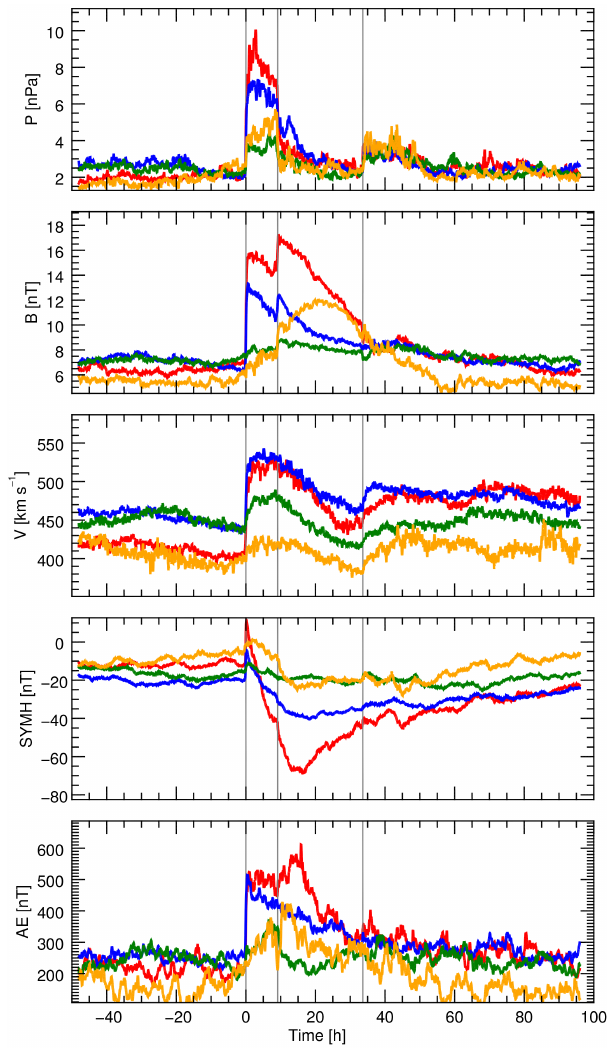
Figure 3. SEAs of three SW parameters ( B , P , V ) and two geo- magnetic indices (SYM-H and AE) for 306 ICMEs between 1996 and 2008. The three vertical lines are the epoch times indicating (re- spectively from left to right) the onset of the sheath, the onset of the ICME, and the end of the ICME. The different colors correspond to different subsets of events: ejecta without shock (87 events) are displayed in green, MC without shock (17) in orange, ejecta with shock (150) in blue, and MC with shock in red